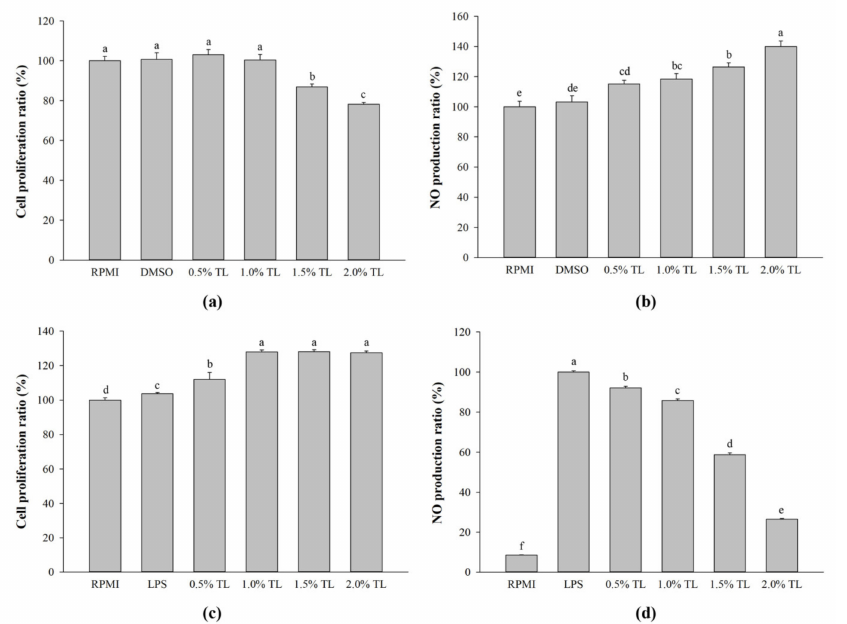
Figure 2. The effects of lipid extracted from A. personatus eggs. ( a ) Cell proliferation in RAW264.7 cells in the absence of LPS stimulation; ( b ) NO production in RAW264.7 cells in the absence of LPS; ( c ) cell proliferation in LPS-stimulated RAW264.7 cells; ( d ) NO production in LPS-stimulated RAW264.7 cells. RAW264.7 cells were pre-treated with various concentrations of lipid. After 1 h, cells were stimulated with or without 1 µ g/mL of LPS for 24 h. Data are presented as means ± standard deviation ( n = 3). The letters a, b, c, and d indicate significant differences ( p < 0.05) between treatment groups. TL = total lipid.